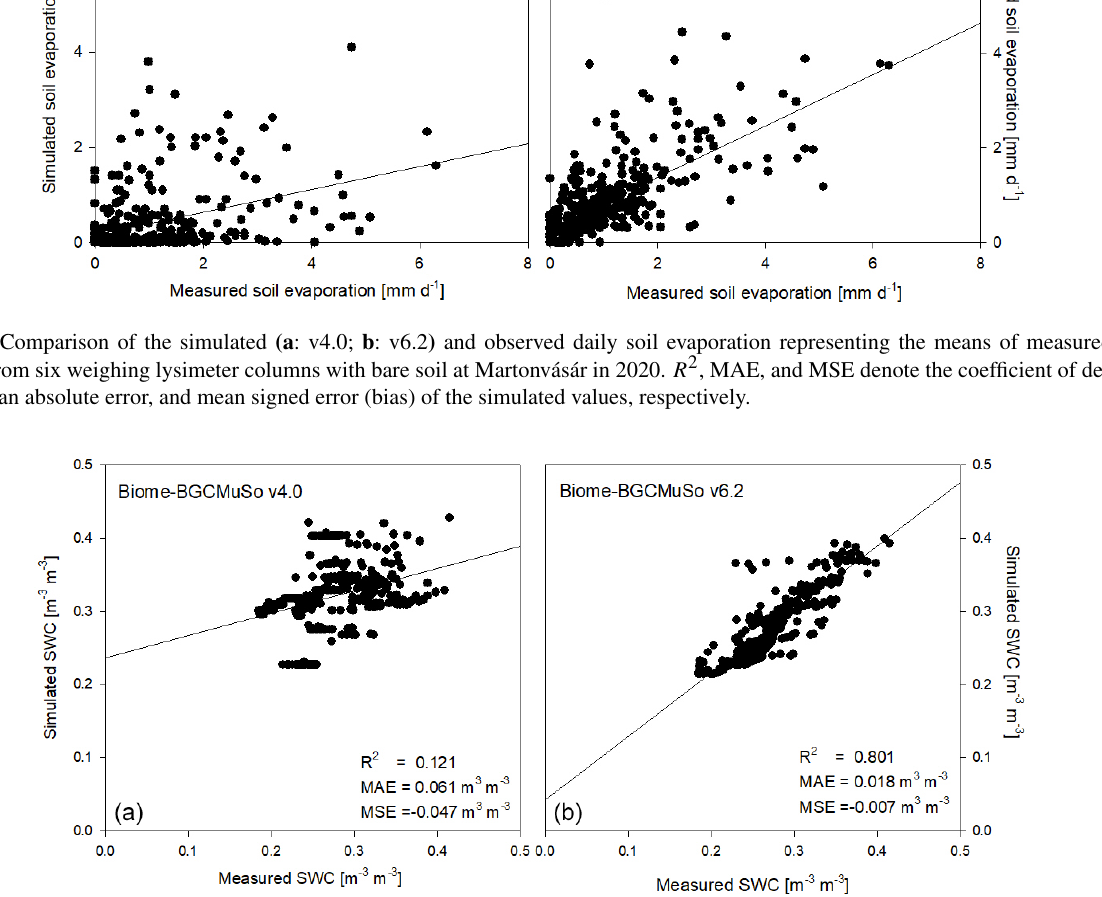
Figure 10. Comparison of the simulated (a : v4.0; b : v6.2 ) and observed daily SWC representing the means of measured data obtained from six weighing lysimeter columns with bare soil at Martonvásár in 2020. R 2 , MAE, and MSE denote the coefficient of determination, mean absolute error, and mean signed error (bias) of the simulated values,